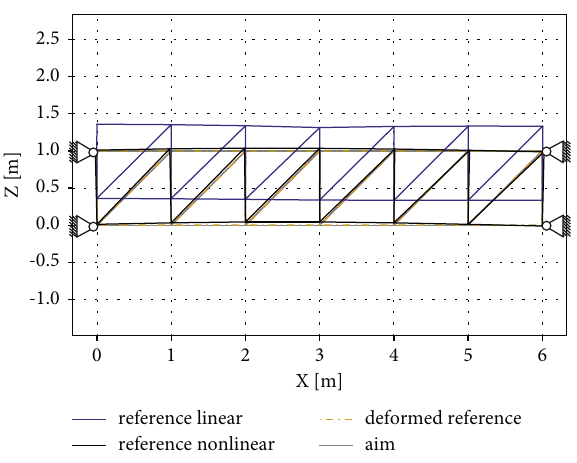
Figure 17: Bridge confgurations in x − z plane for y � 1.